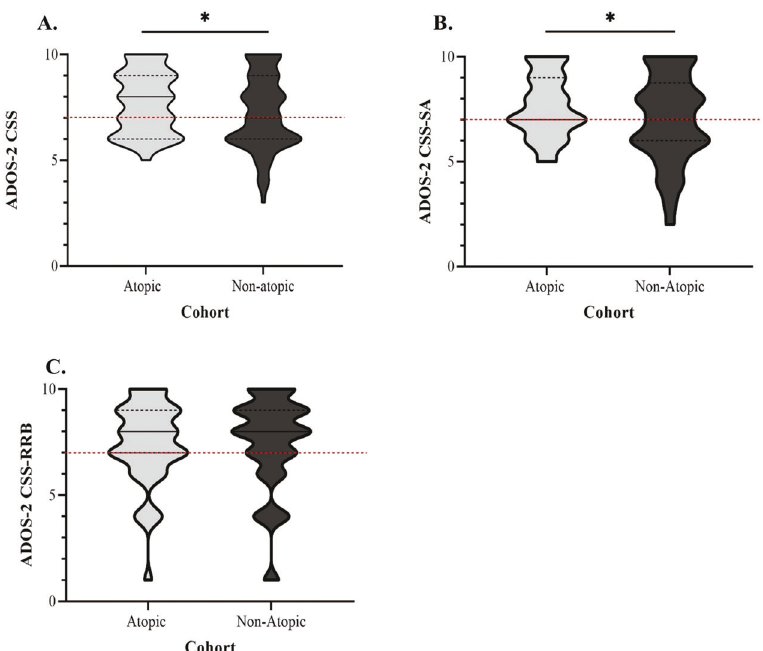
Fig. 1 Distribution of ADOS scores in the atopic ( n = 47) and non-atopic cohorts ( n = 93). Children with an atopic comorbidity scored signi fi cantly higher on the A . ADOS-2 CSS ( p = 0.039) and B . CSS-SA ( p = 0.046) relative to those without an atopic disorder. No signi fi cant differences were detected in C . CSS-RRB scores between the atopic and non-atopic cohorts ( p = 0.943). All p values are reported for a difference in mean between the atopic and non-atopic cohort, as determined using bootstrapped Welch two independent-sample t -tests. * p < 0.05. The black solid lines represent the median and the black dotted lines represent the quartiles. The horizontal red dotted line represents the threshold for severe ASD-related symptomatology of the ADOS (CSS = 7 or above). The width of the curves corresponds to the frequency of each ADOS score. Percentage missing data for full cohort: ADOS-2 all scales